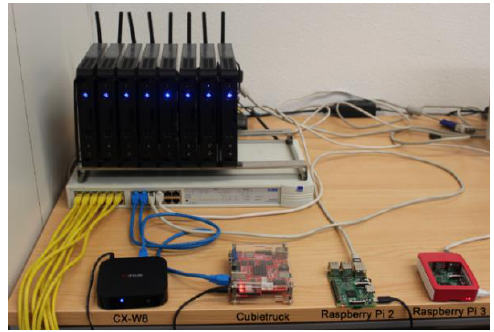
Figure 7. First testing scenario.